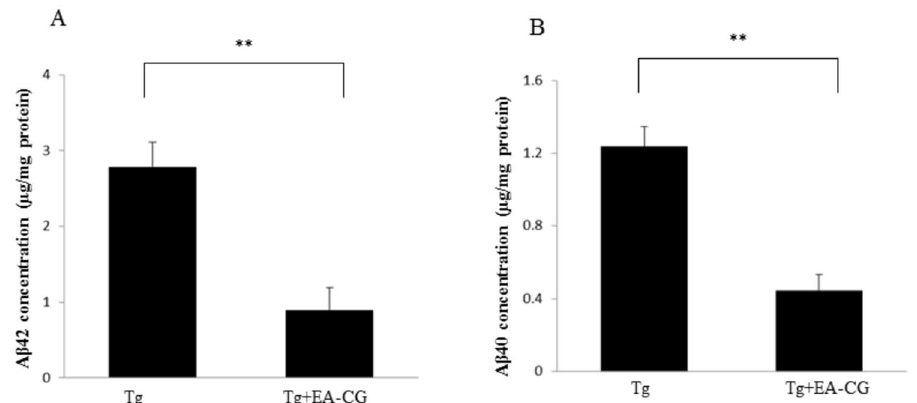
Fig 6. Comparison of Soluble A β 42/40by the CG extractson Tg mice brain. The cerebralA β 42(A)and A β 40 (B) load was quantitatedby capturingantigensuch as Amyloid beta 42 and/or Amyloidbeta 40 mediatedEnzyme-Linked Immunosorbent Assay (ELISA) kit (Invitrogen, CA) using brain lysates (i.e., total brain lysate of hippocampus and neocortex area) from the EA-CG-treated or vehicle(PBS)-treated Tg (Mo/Hu APPswe PS1dE9) mice. The cerebralA β 42 concentrations in the EA-CG-treated mice were significantly reducedcompared to the vehicle-treated controls ( ** P < 0.01). The values shown were the means ± S.E.M. (n = 10 per